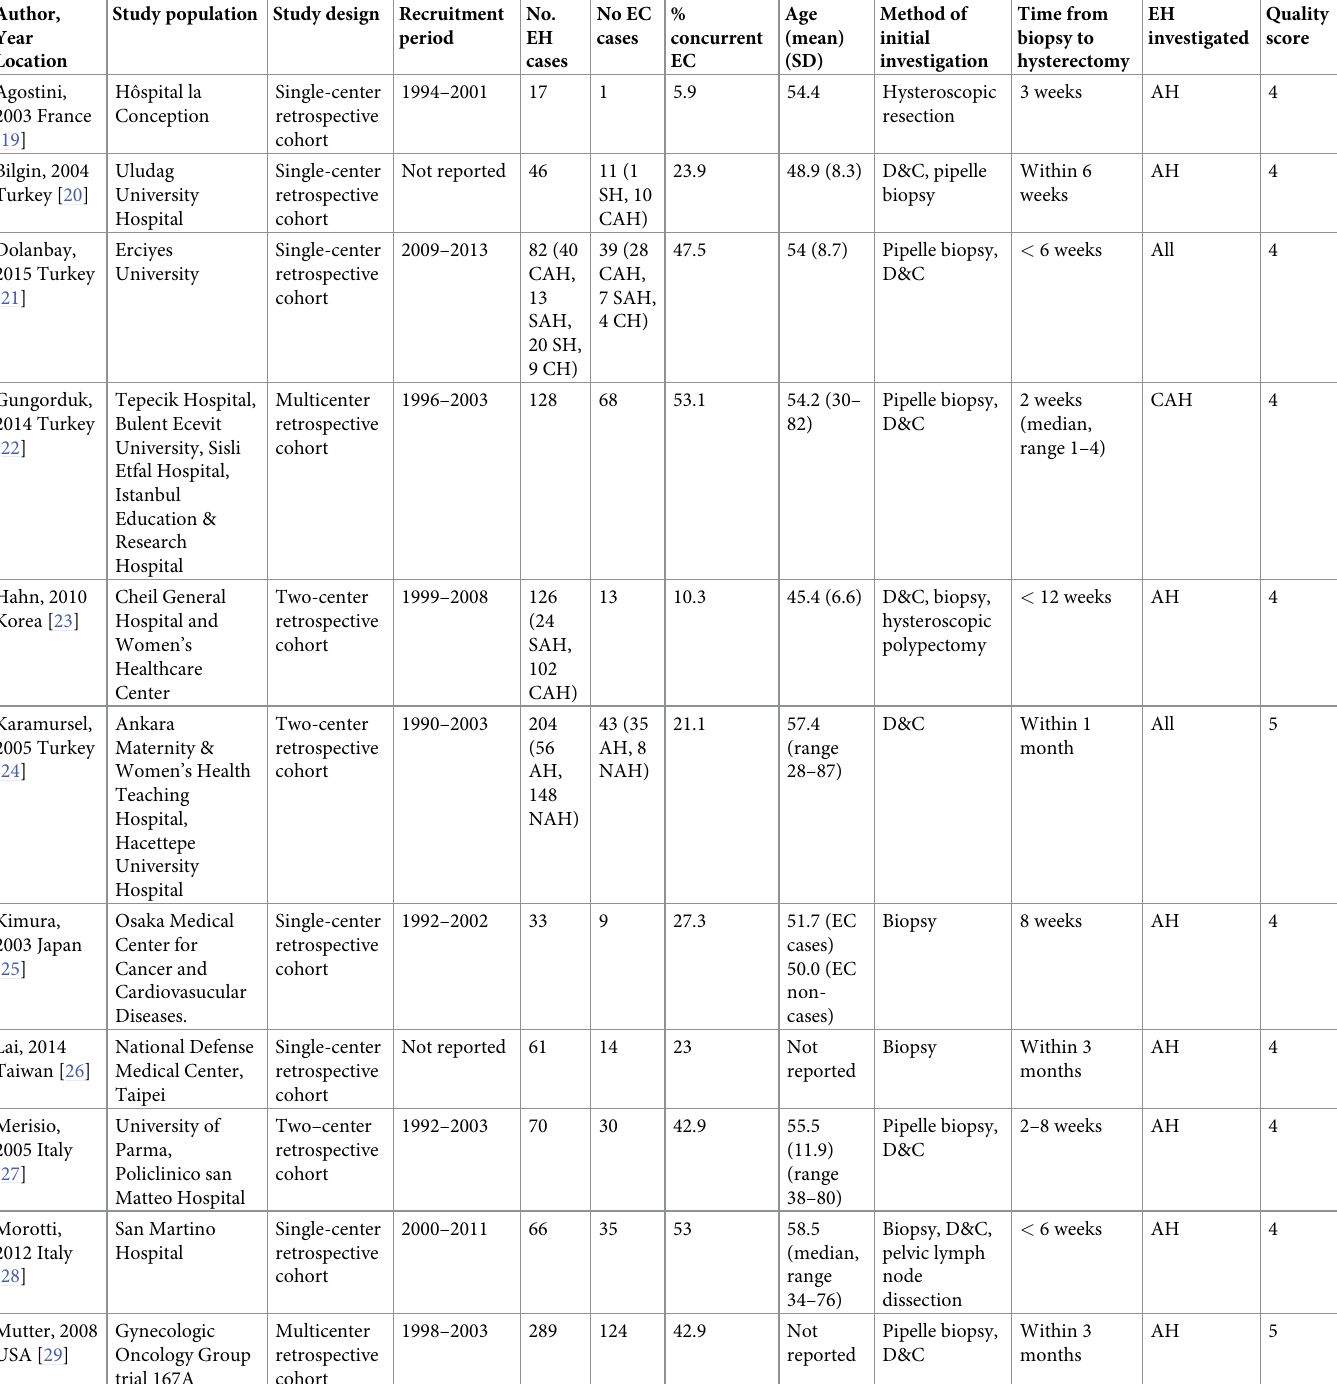
Table 1. Characteristics of studies which assessed the prevalence of concurrent endometrial cancer in women with endometrial hyperplasia (n =